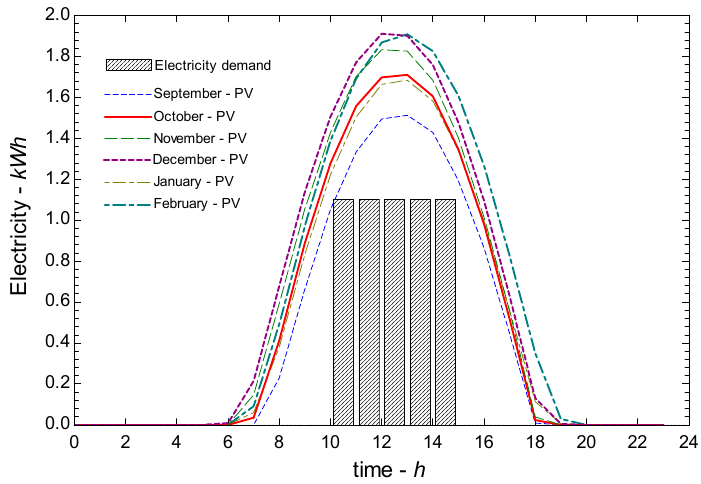
Figure 3. Daily energy performance of Experimental Unit (EU 2) on days with irrigation (off-grid PV system). Table 6. Electrical power required by the photovoltaic (PV) system used in each EU.